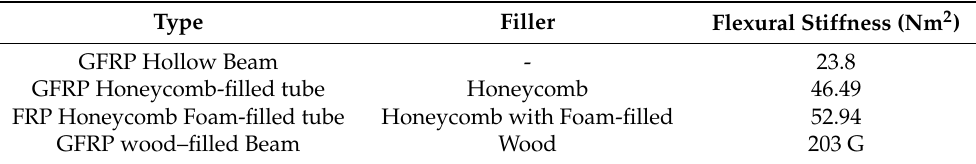
Table 4. Flexural stiffness properties of FRP/GFRP beams/panels with different core-filled struc- tures